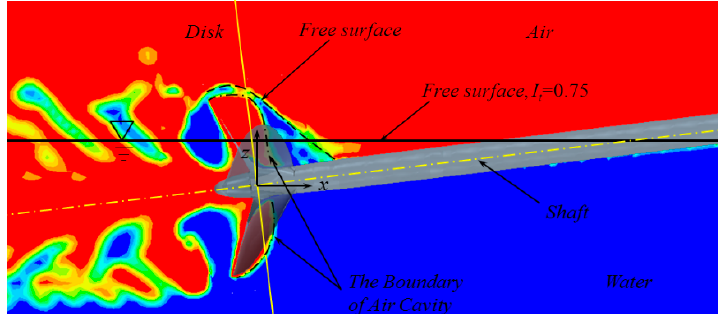
Water 2019 , 11 , x FOR PEER REVIEW Figure 9. Gas-liquid distribution on the xz plane at J = 0.8. Figure 9. Gas-liquid distribution on the xz plane at J = 0.8.